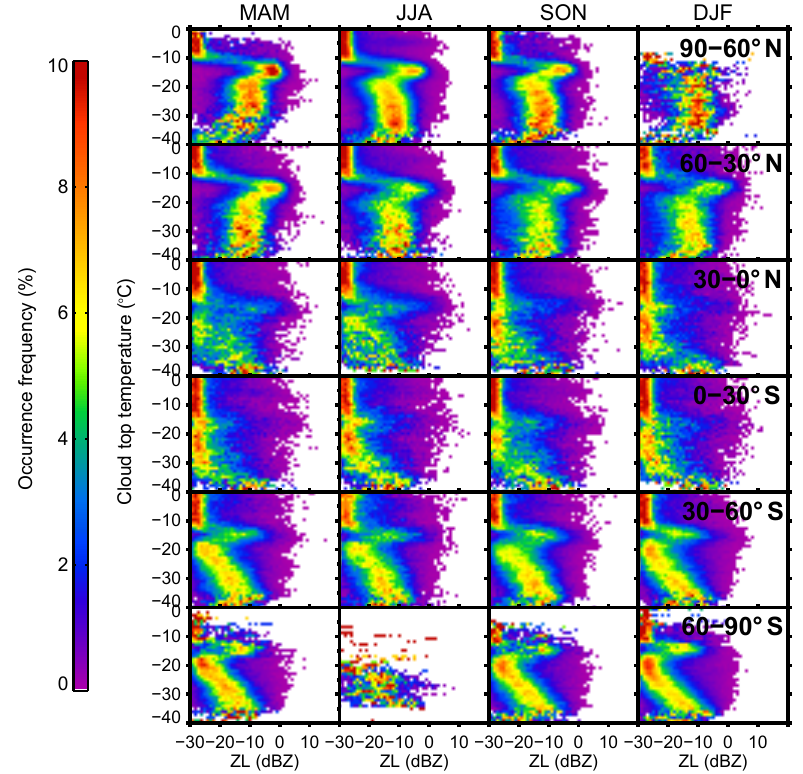
Figure 6. Similar to Fig. 3a, except for the seasonal variation in stratiform mixed-phase cloud ice production statistics.